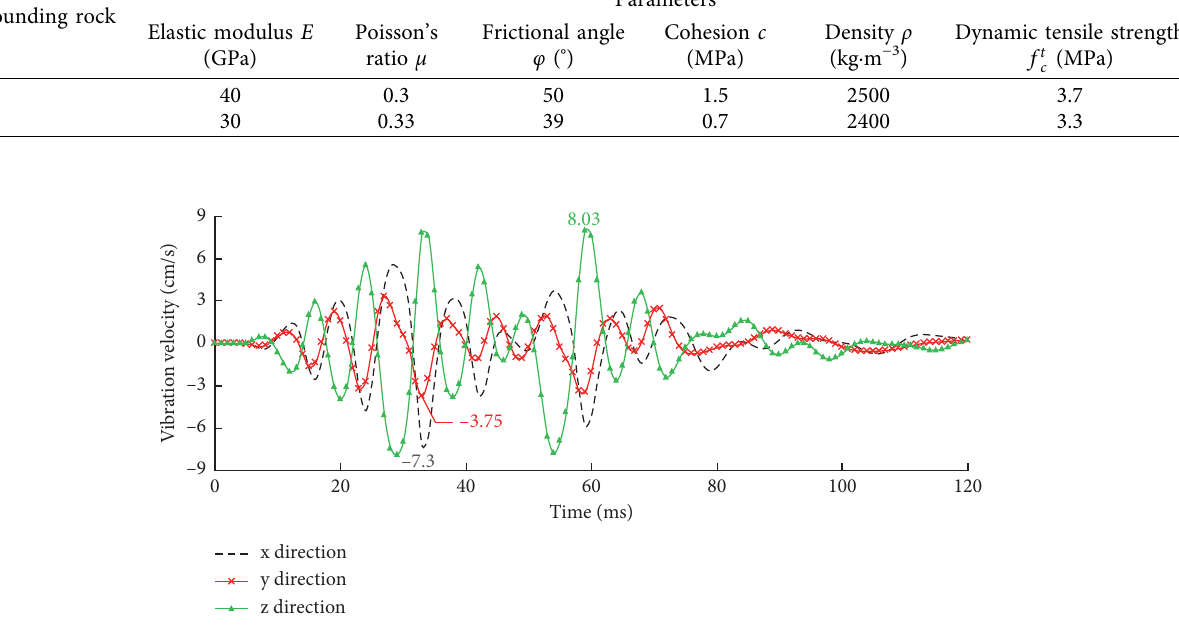
Figure 8: Time-history curve of the numerically simulated particle velocity at 1# monitoring